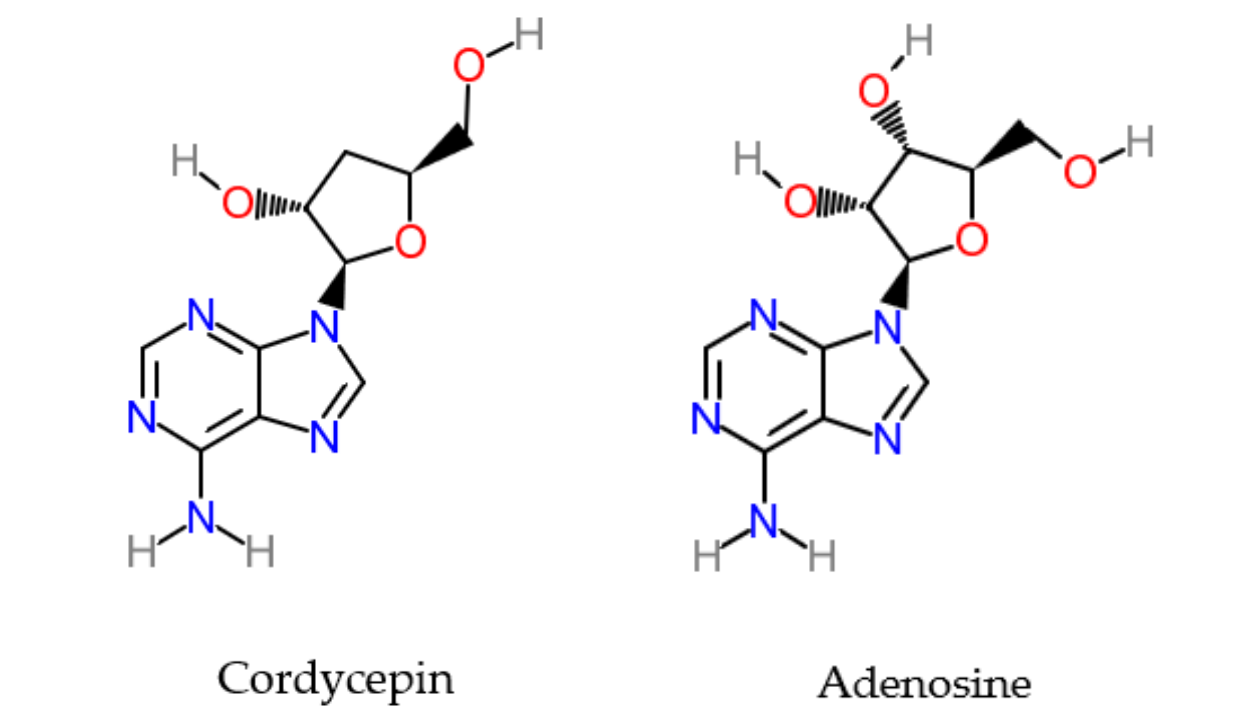
Figure 1. Chemical structures of cordycepin (Cor) and adenosine (Ado)